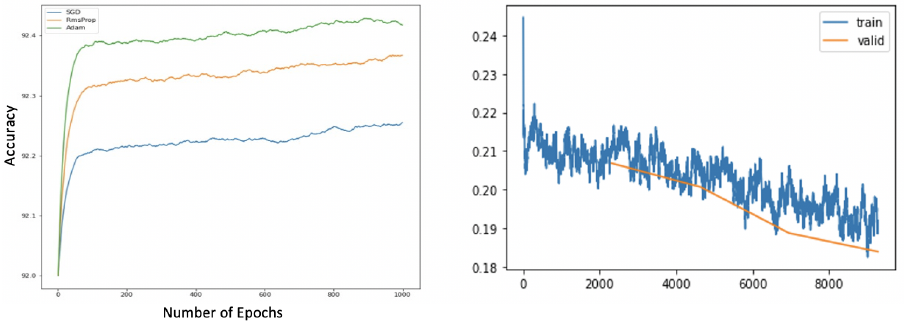
Figure 5. The accuracy of BoTNet.